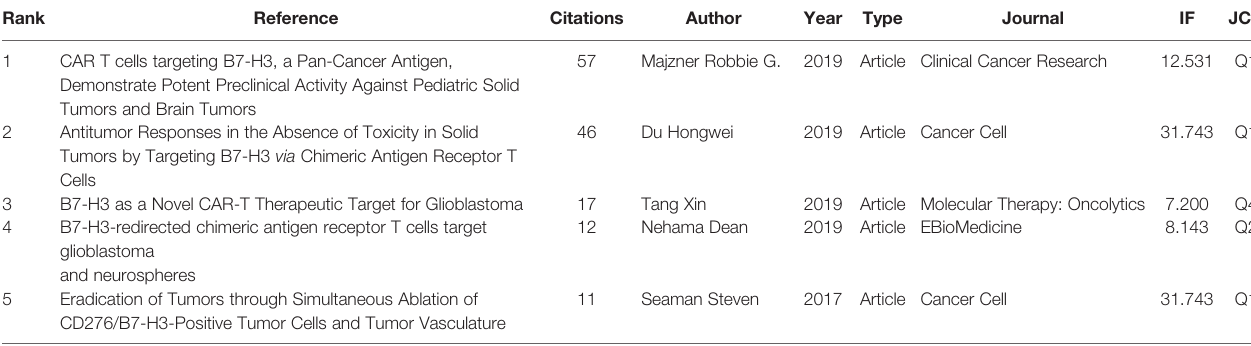
TABLE 6 | Cited References in cluster 15 of the overlay analysis of co-cited references and